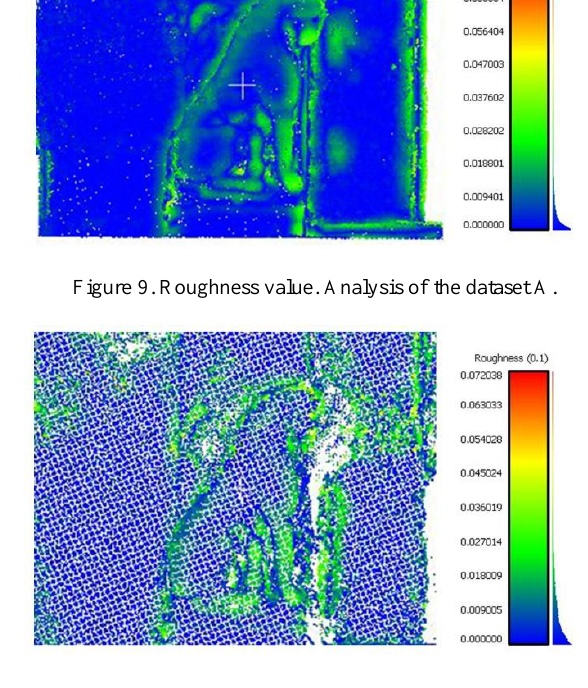
Figure10. Roughness value. Analysis of the dataset